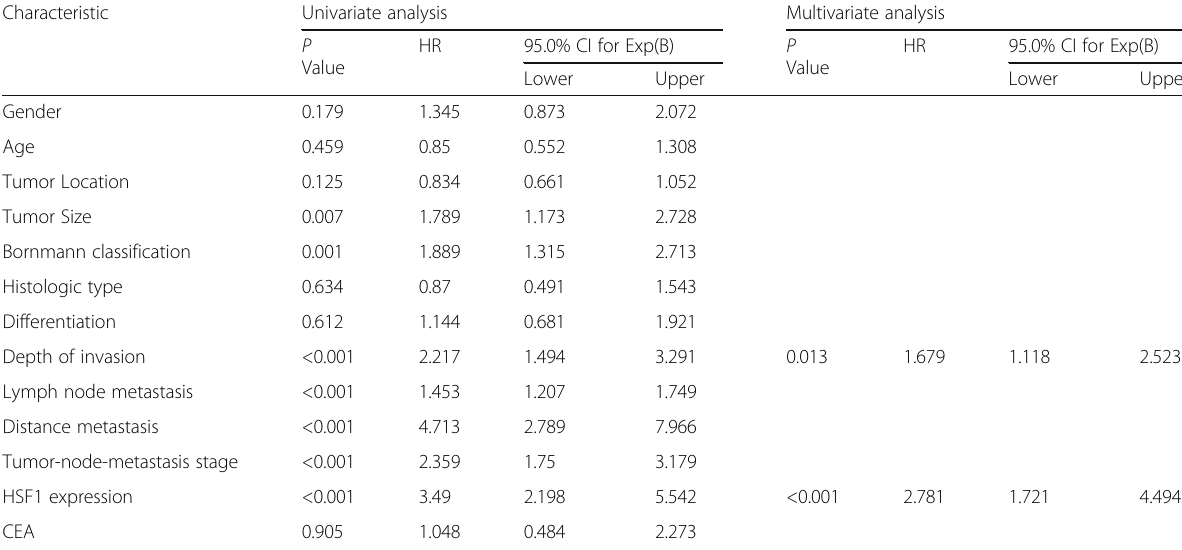
Table 3 Cox proportional-hazard regression analysis for Recurrence Free Survival